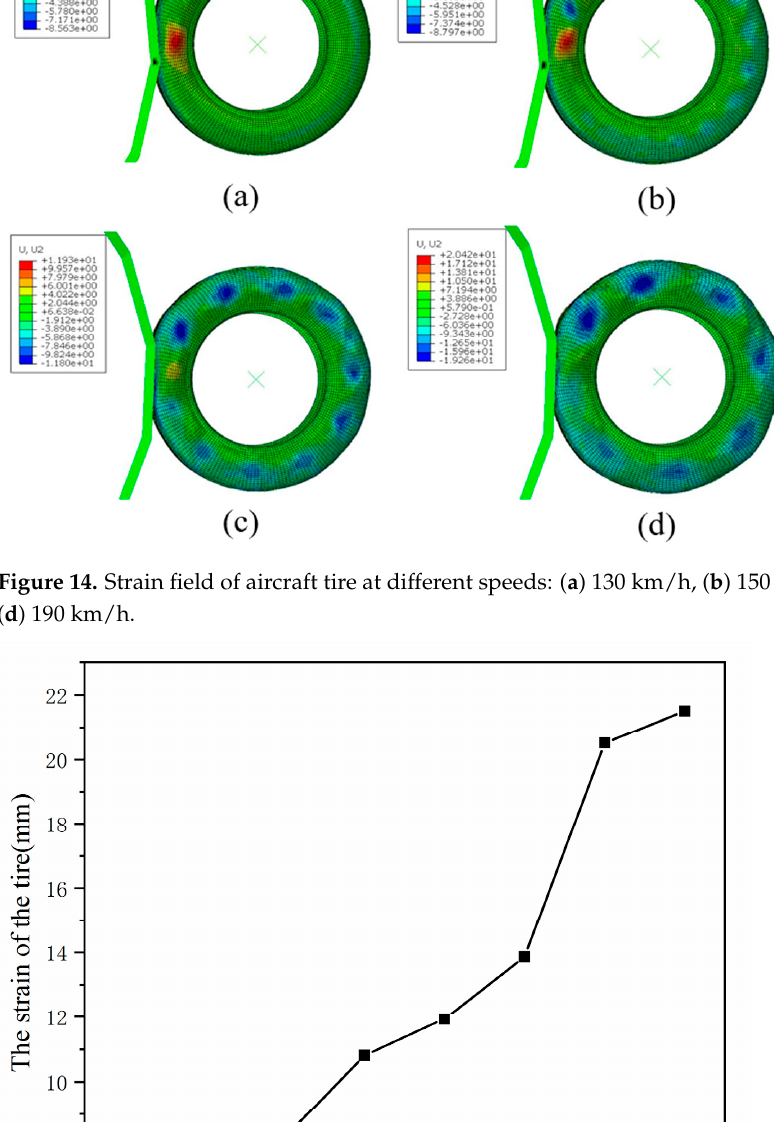
Figure 15. The strain changes of aircraft tire at different speeds.